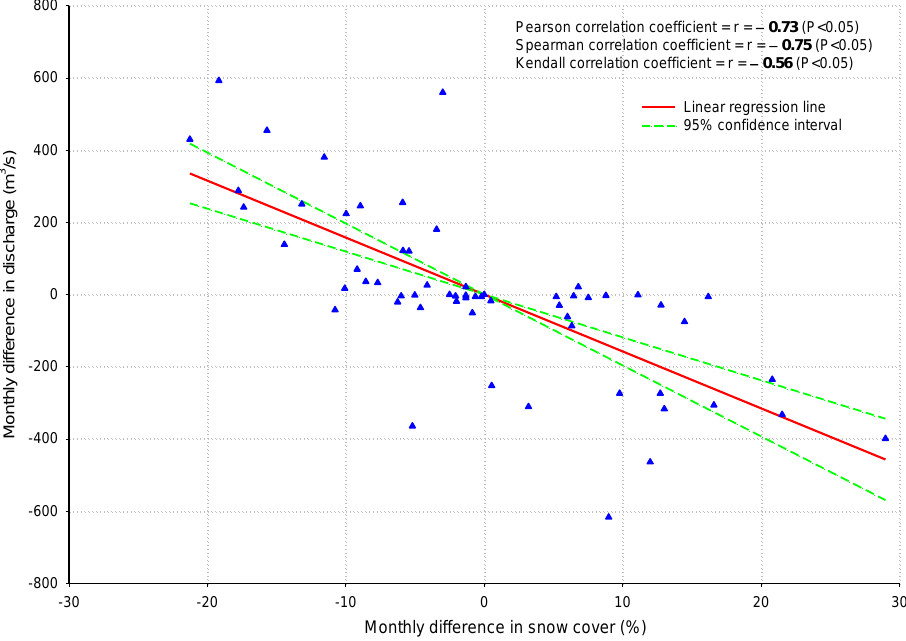
Fig. 8. Correlation between monthly difference in snow cover and monthly difference in discharge at Dainyor in the Hunza River basin. All the correlation values are significant with a significance level, p <0.05.